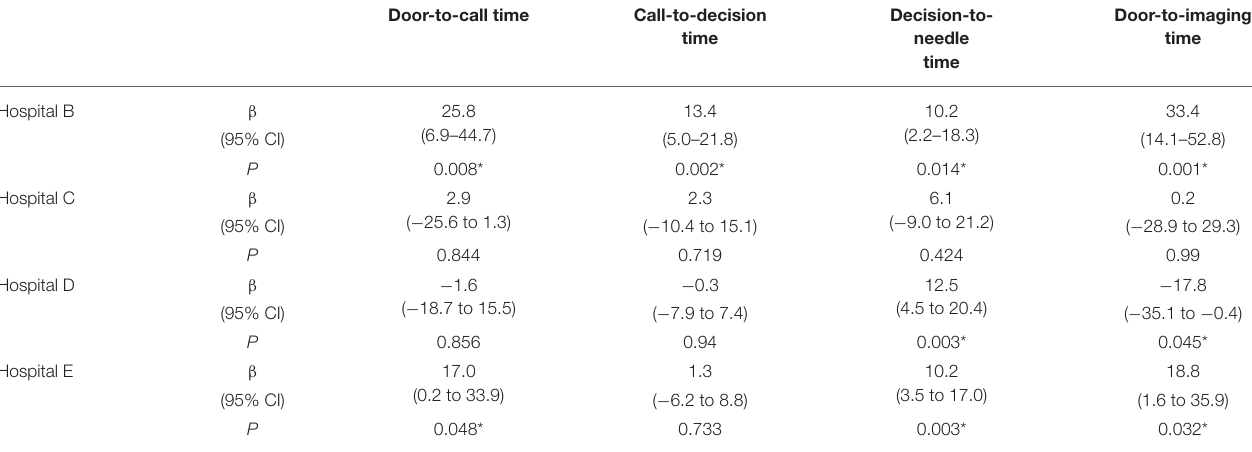
TABLE 5 | Estimated differences in work-flow times relative to Hospital A after adjusting for other variables (* P < 0.05).